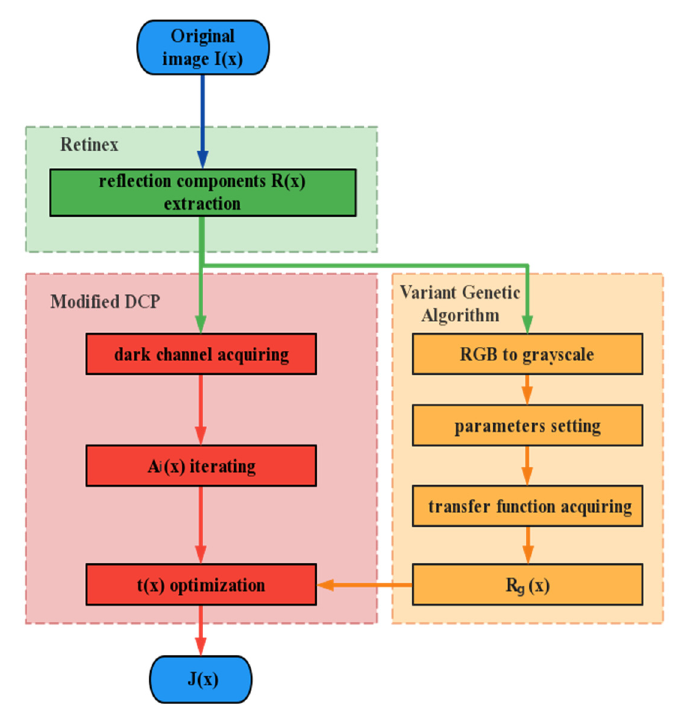
Figure 1. The hybrid dark channel prior algorithm.